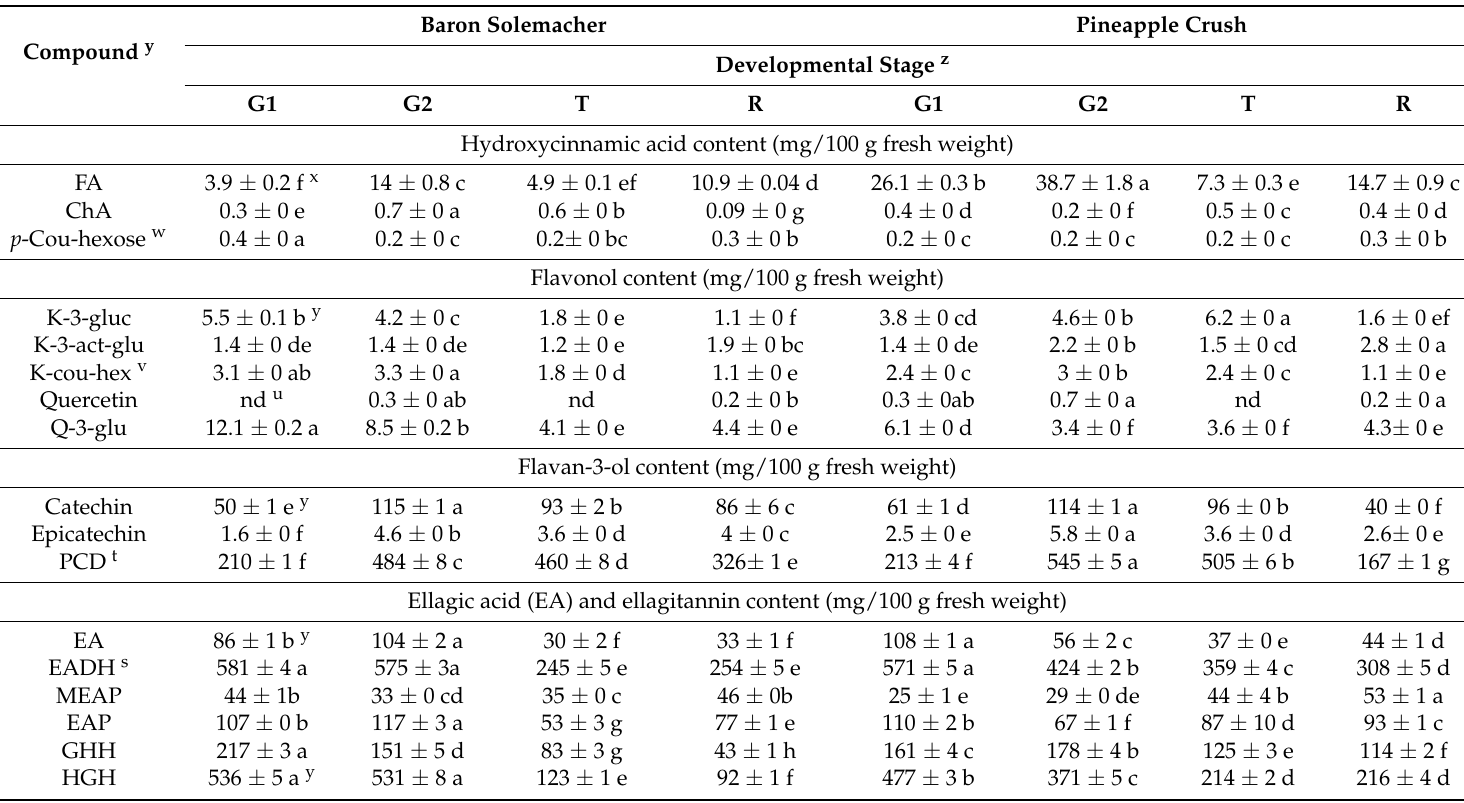
Table 2. Individual polyphenol content of the Fragaria vesca genotypes red-fruited Baron Solemacher and white-fruited Pineapple Crush.